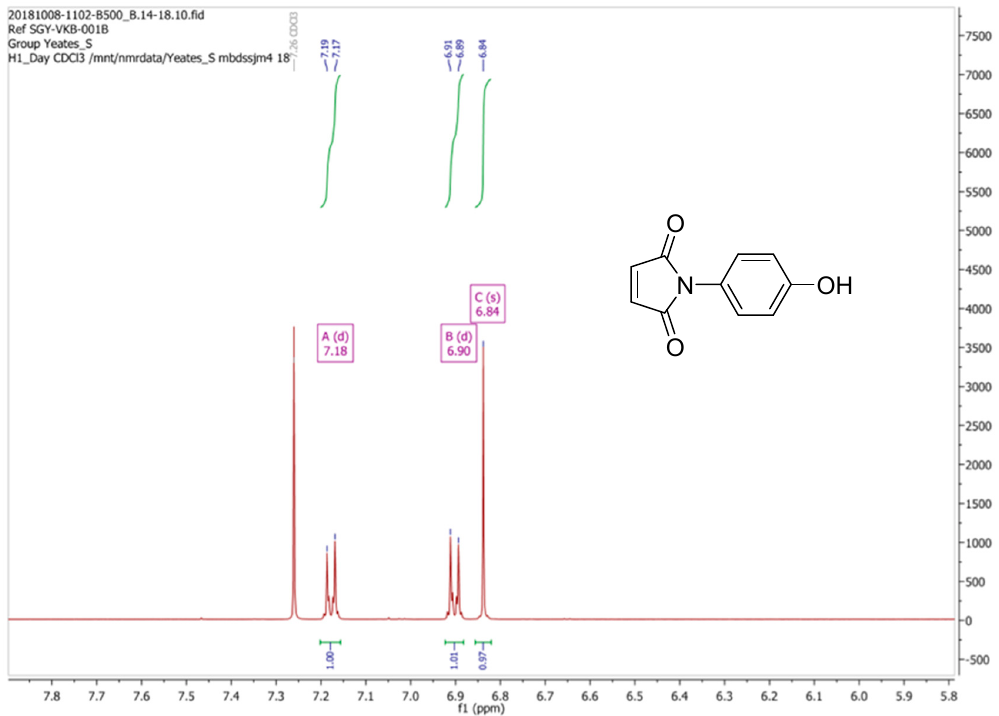
Figure 2. 1 H-NMR spectrum of N -(4-Methylphenyl)maleimide ( 2 ) as prepared in this study ( recorded in CDCl 3 ).